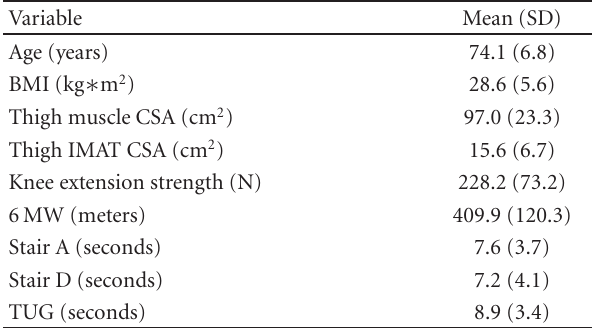
Table 1: Characteristics of the 109 participants (females n = 77, males n = 32). body mass index (BMI), cross-sectional area (CSA), six minute walk (6MW), stair ascent (stair A), stair descent (stair D), timed up and go